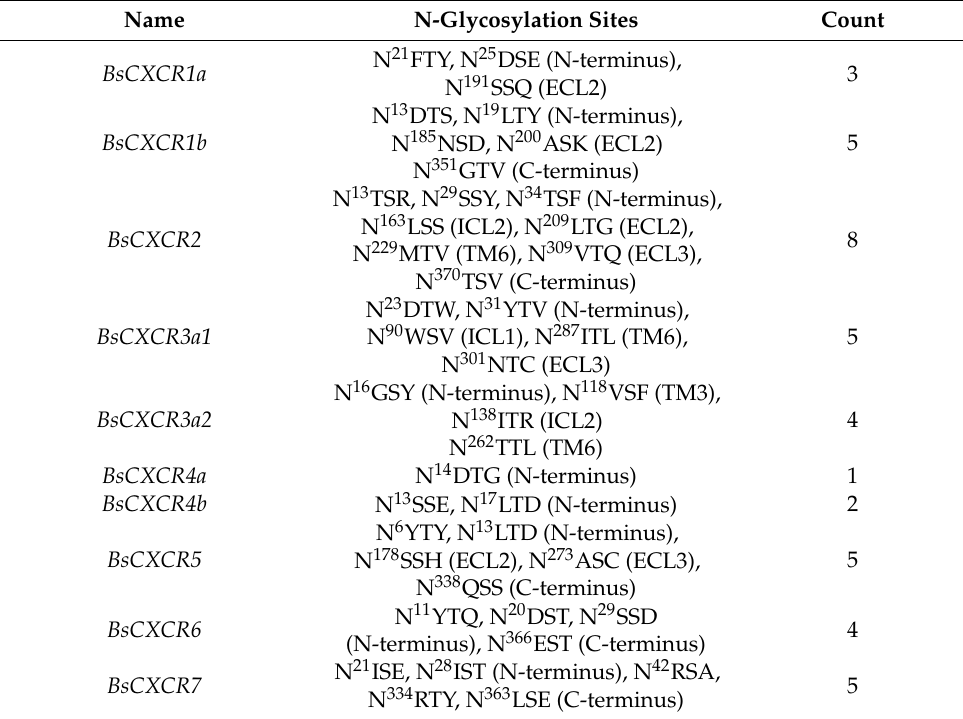
Table 1. Prediction of N-glycosylation sites in BsCXCR proteins.